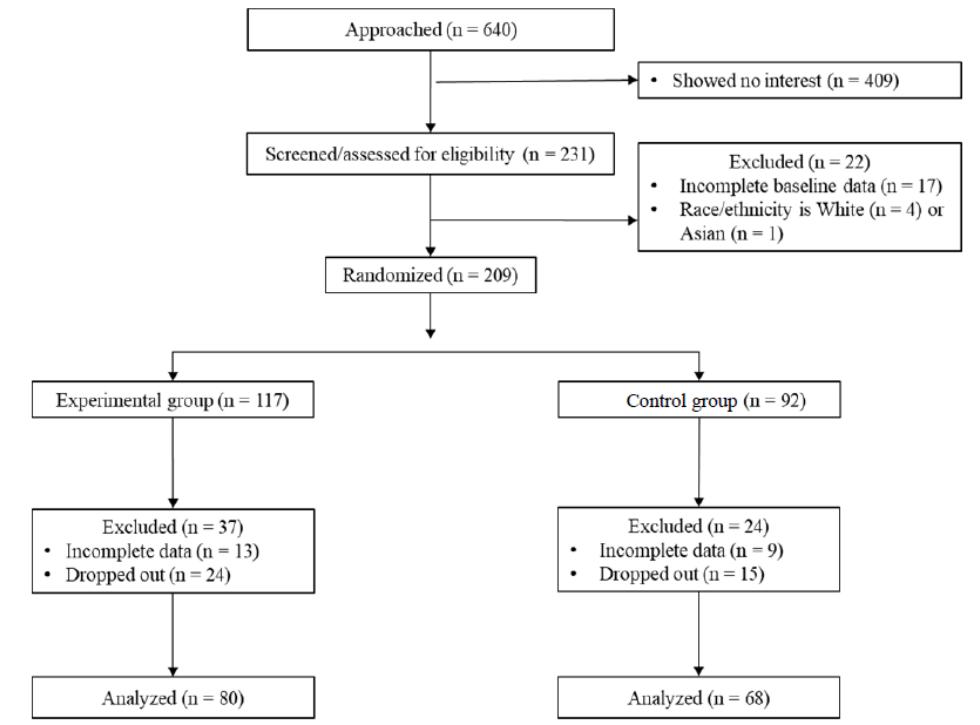
Figure 1. CONSORT Flow Diagram.